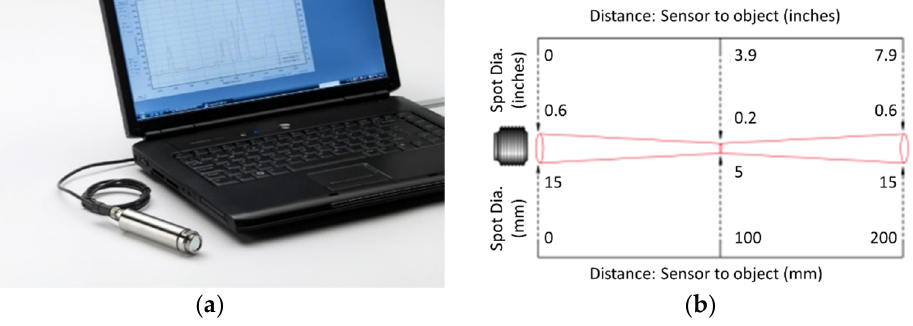
Figure 6. ( a ) Calex PUA8-CF temperature sensor connected with PC via USB; ( b ) sensor optics.